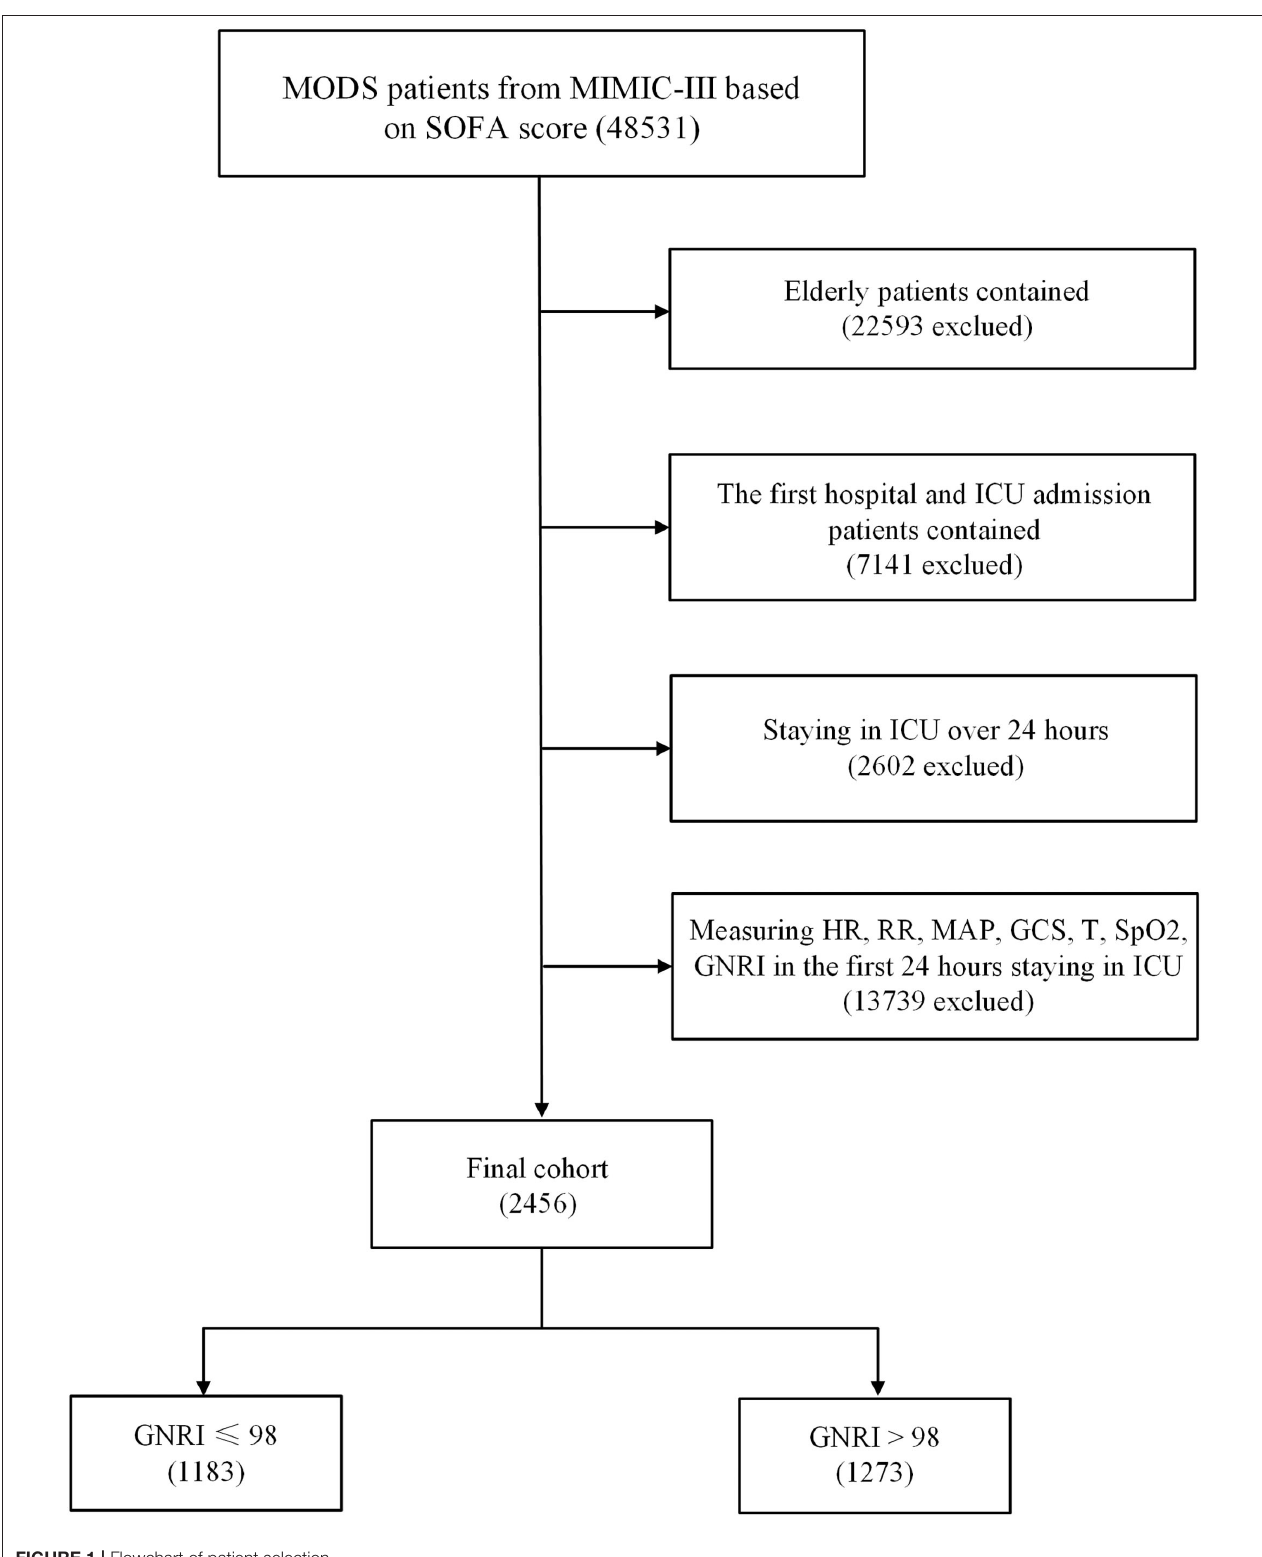
FIGURE 1 | Flowchart of patient